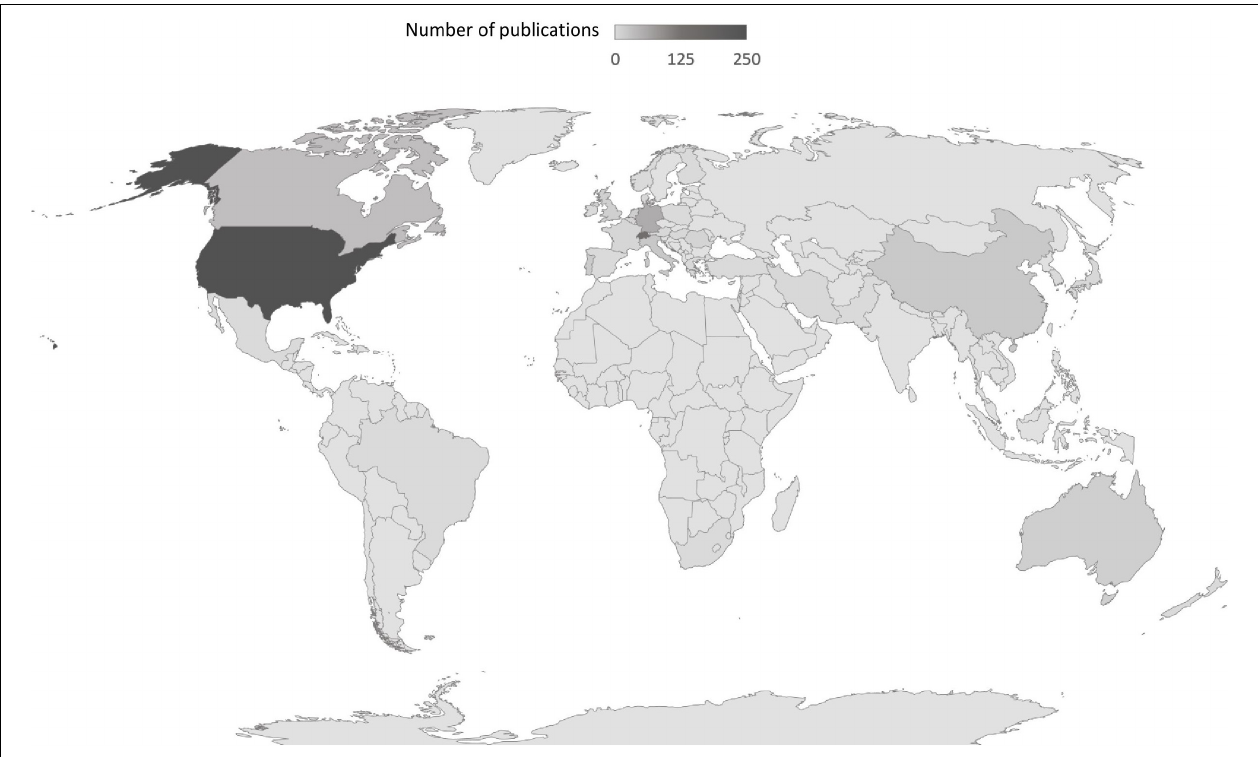
FIGURE 2 | Number of publications about dyadic coping (DC) around the world. Darker areas stand for greater number of publications; light gray areas represent countries without any DC publications (Figure powered by Bing© GeoNames, Microsoft, TomTom, Wikipedia).